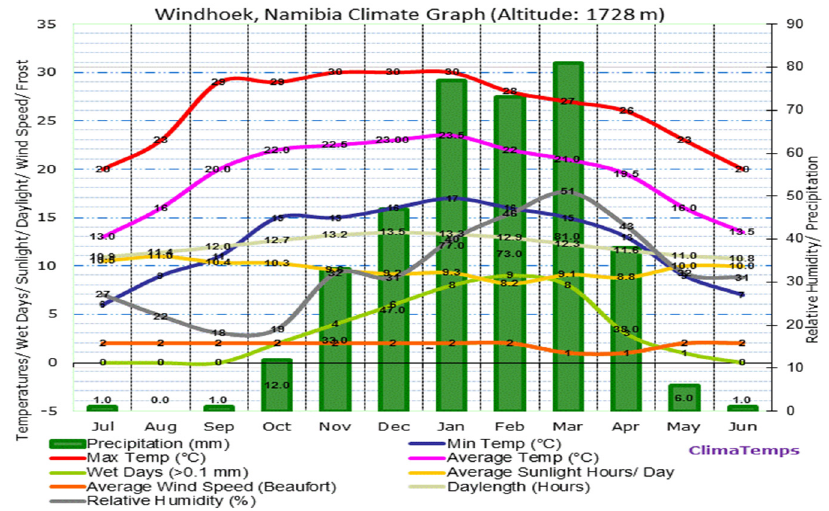
Figure 8. Climate pattern for Windhoek. Source [95]. The average wind speed for the site ranged from 4.34 to 6.50 m/s (Figure 9), with an annual average of 6.31 m/s. This translates between wind power classes 2 and 3, which can generate marginal to fair wind output.